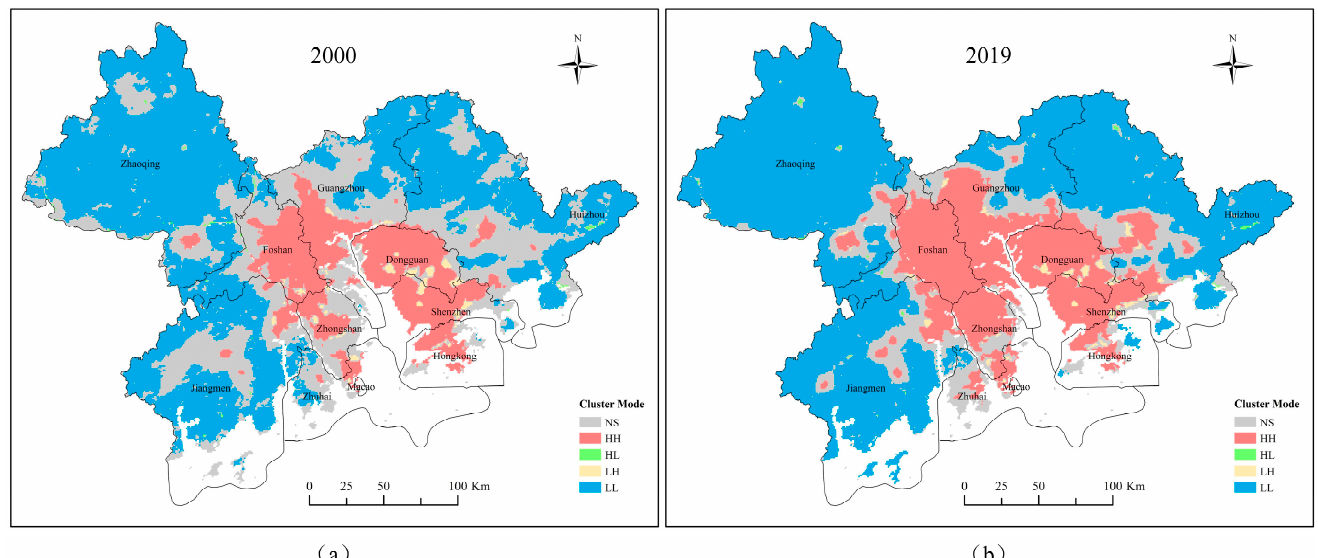
Figure 9. Changes of Local Moran’s I: ( a ) 2000 and ( b ) 2019 in the study area. Distinctive changes in the HH cluster appear in ISA% for Guangzhou, Foshan, Jiangmen, Zhongshan, and Huizhou, suggest a considerably increased ISA%. In addition, we calculated the Local Moran’s I for Huizhou, Guangzhou, and Zhuhai. We selected these three cities because of their representativeness, given their different urbanization and levels of spatial autocorrelation in the ISA%. The changes in their spatial clustering of ISA% over time are displayed in Figure 10. We observed a notable change in HH clusters from 2000 to 2019 in Huizhou. The expansion of HH clusters in Guangzhou demonstrated an uptrend from 2000 to 2010 but maintained a stable level from 2010 to 2019. In comparison, changes in Zhuhai were not as clear as in the other two cities.